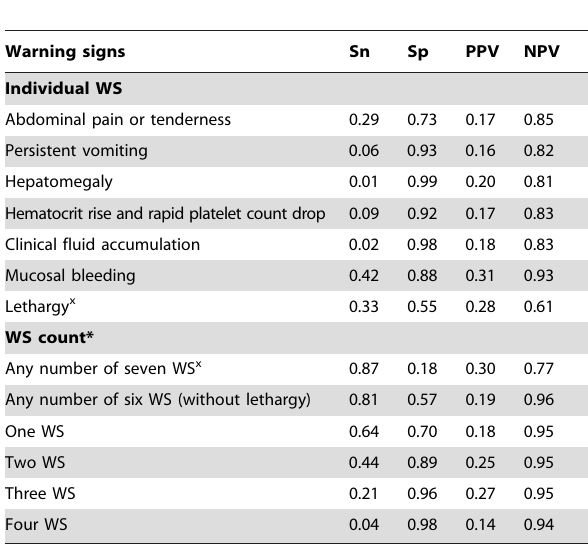
Table 3. Performance of warning signs (WS) for predicting dengue hemorrhagic fever (DHF) (n =1507).